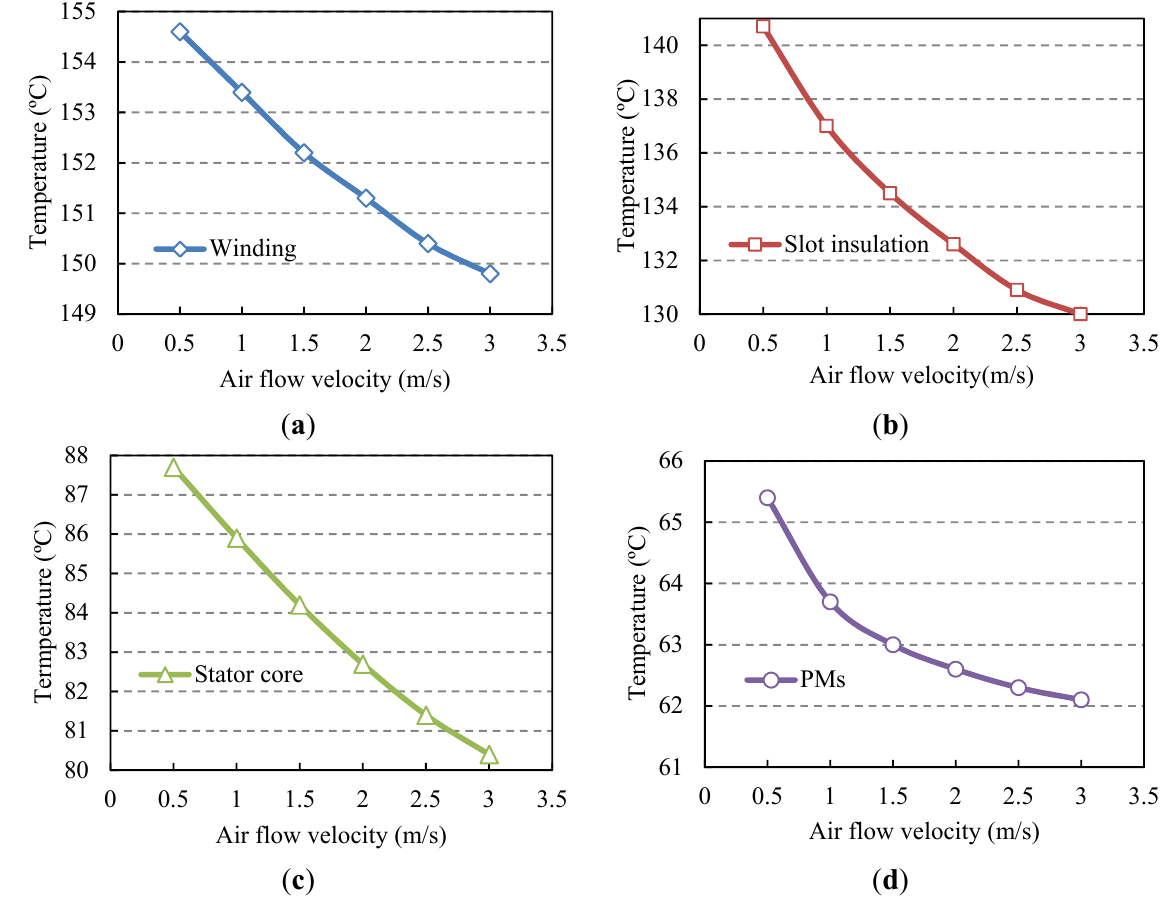
Figure 23. The maximum temperatures of different parts vs. air flow velocity: ( a ) winding; ( b ) slot insulation; ( c ) stator core; and ( d )